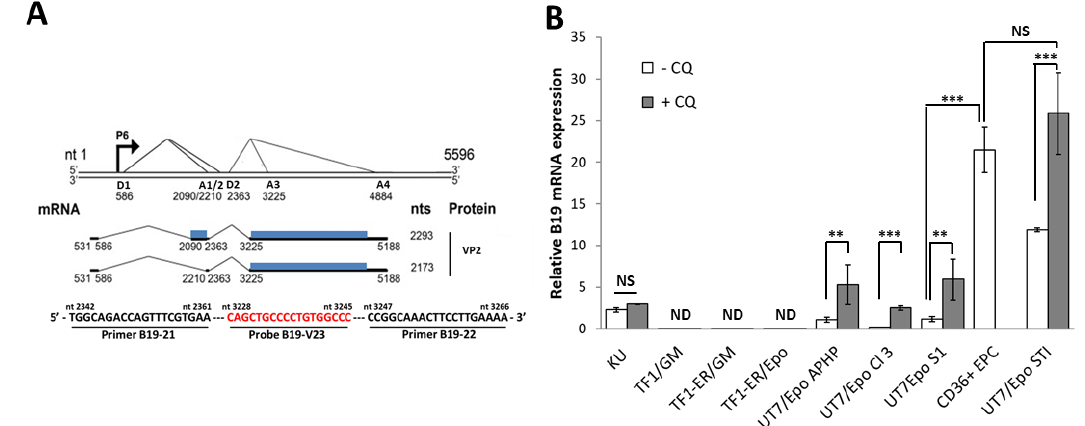
Figure 1. Comparison of the B19V sensitivity and permissiveness of hematopoietic cell lines. ( A ) B19V transcription profile (adapted from Ganaie et al., J Virol. 2018 [7]). The major transcription unit of the B19V duplex genome (GenBank accession no. AY386330) is shown to scale at the top, with the P6 promoter, 2 splice donors (D1, D2) and 4 acceptors (A1 to A4) sites. In blue, mRNA encoding the VP2 viral proteins, with nucleotides (nts). At the bottom, the primers and probe used for the RT-PCR amplification of VP2. ( B ) Bone marrow-derived primary Erythroid Progenitor Cells (CD36 + EPCs), human leukemic cell lines (TF1, TF1-ER, UT7 / Epo-APHP, UT7 / Epo-STI) and isolated clones (KU812Ep6, UT7 / Epo-cl3 and UT7 / Epo-S1) were seeded in triplicate and inoculated with or without B19V in culture medium supplemented with Epo (2 U / mL)( / Epo), or granulocyte macrophage colony-stimulating factor (GM-CSF) (25 ng / mL)( / GM) for TF1 and TF1-ER. When specified, cells were cultivated with ( + ) or without (-) Chloroquine (CQ, 25 µ M). No CQ treatment was applied to CD36 + EPC. 72 h post-infection, cells were pelleted and lysed. RNA was extracted and analyzed by RT-qPCR for VP2 to quantify B19 viral genome expression, and for β -actin for cell number normalization. For each cell line, the results without B19V correspond to the negative control. Relative B19V threshold cycle (Ct) values were normalized relative to b-actin Ct and expressed according to the 2 − ∆∆ Ct method with normalization against mean VP2 expression for UT7 / Epo-S1 cells without CQ ( n = 6).